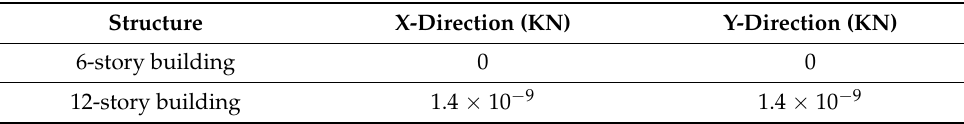
Table 7. Base shear comparison from the static linear analysis.